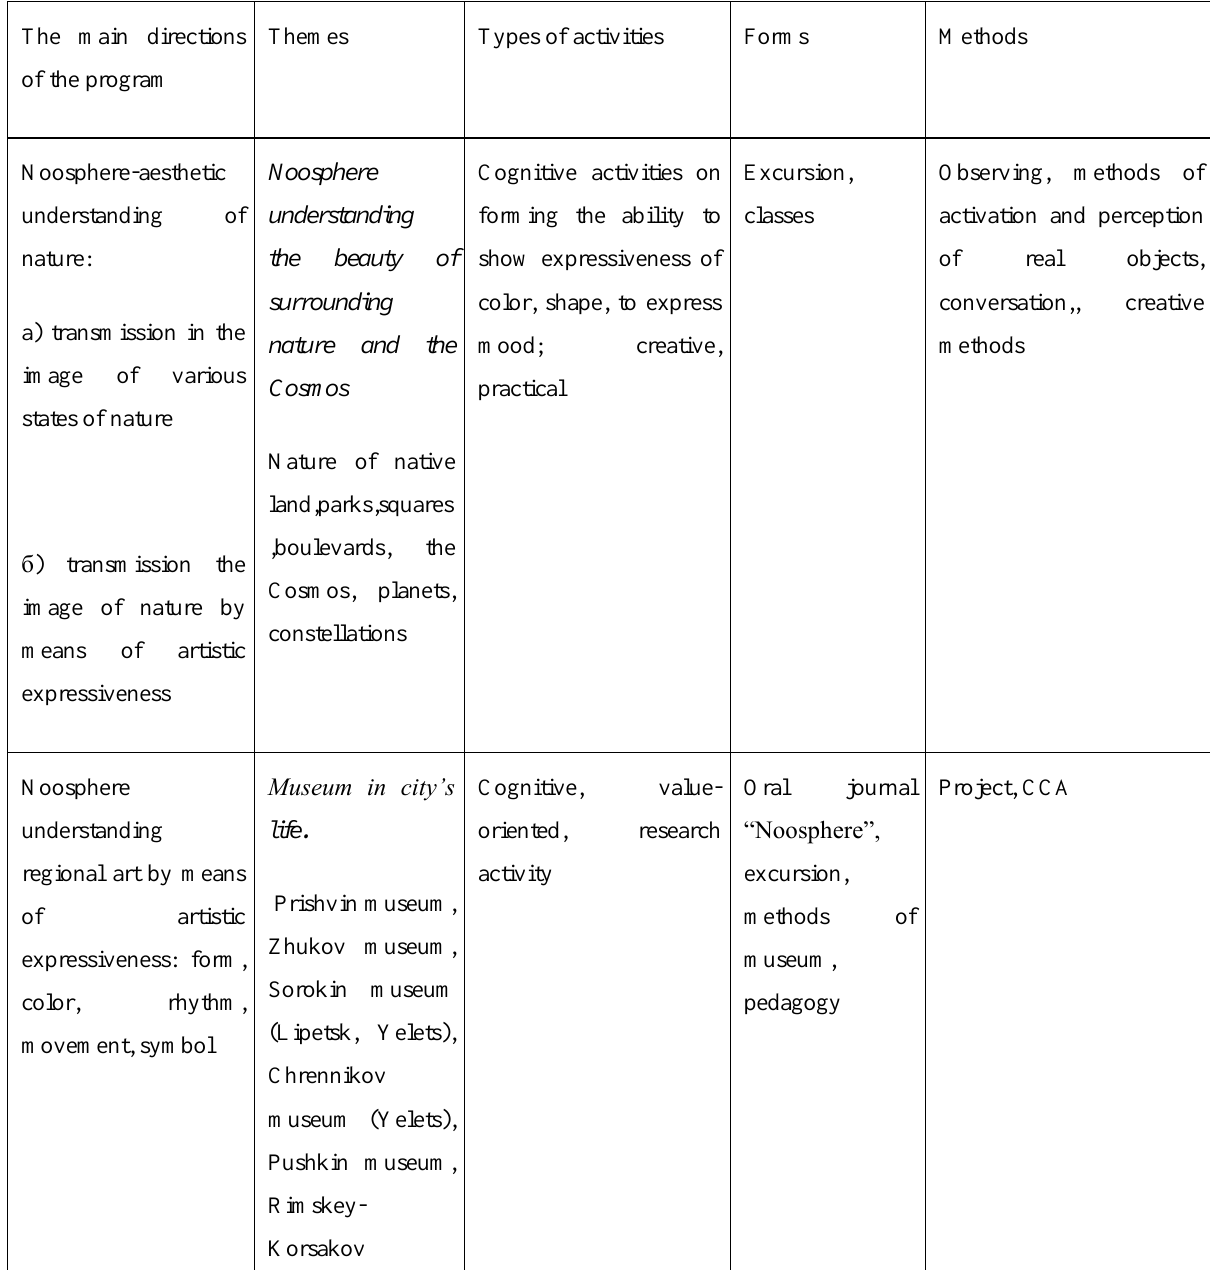
Table 1. Technological block of the model of noosphere-aesthetic education primary school students by means of regional